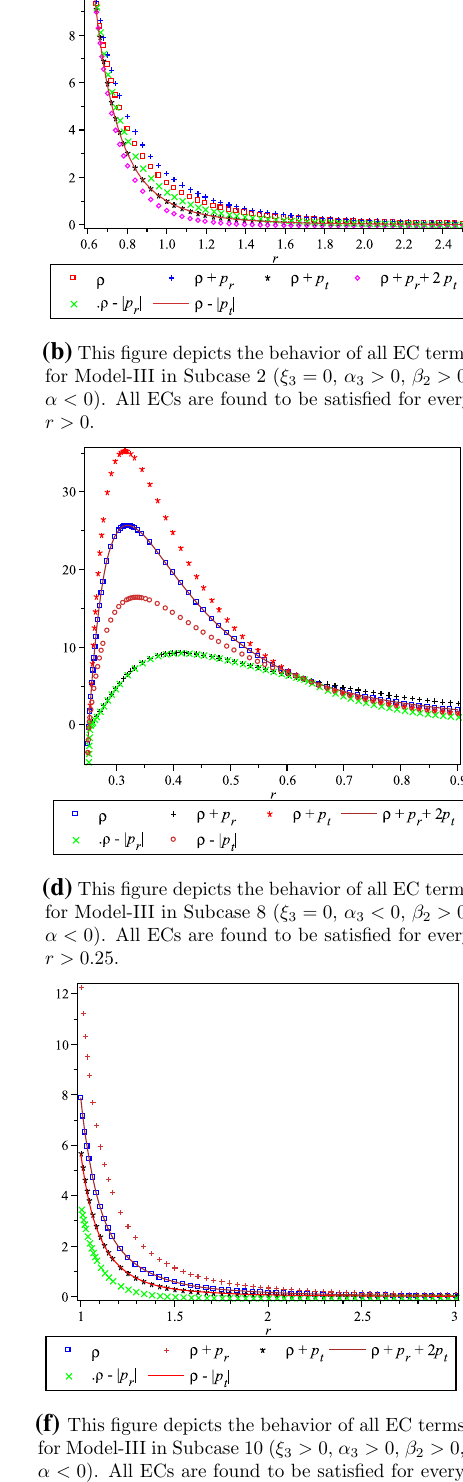
Fig. 3 EC terms for 15 subcases of ρ = α 3 R 2 + β 2 R (cid:2) e ξ 3 R